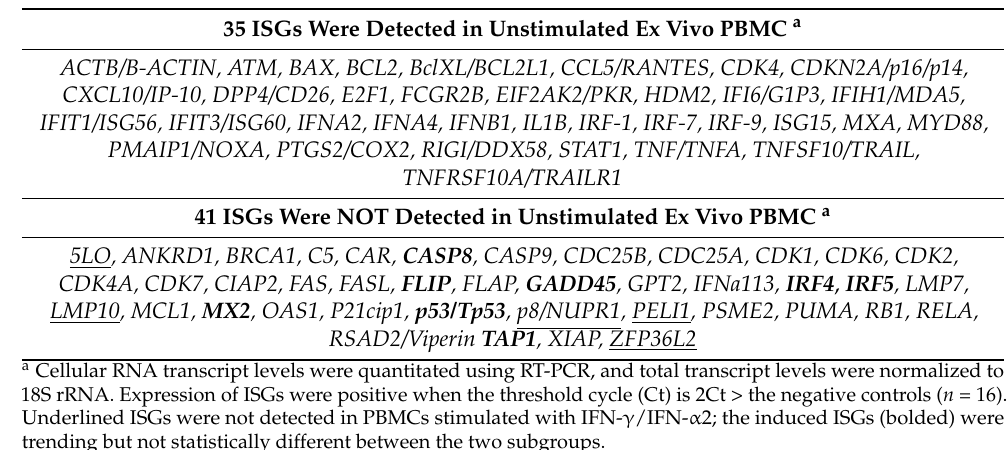
Table 2. List of ISGs expressed in the unstimulated ex vivo